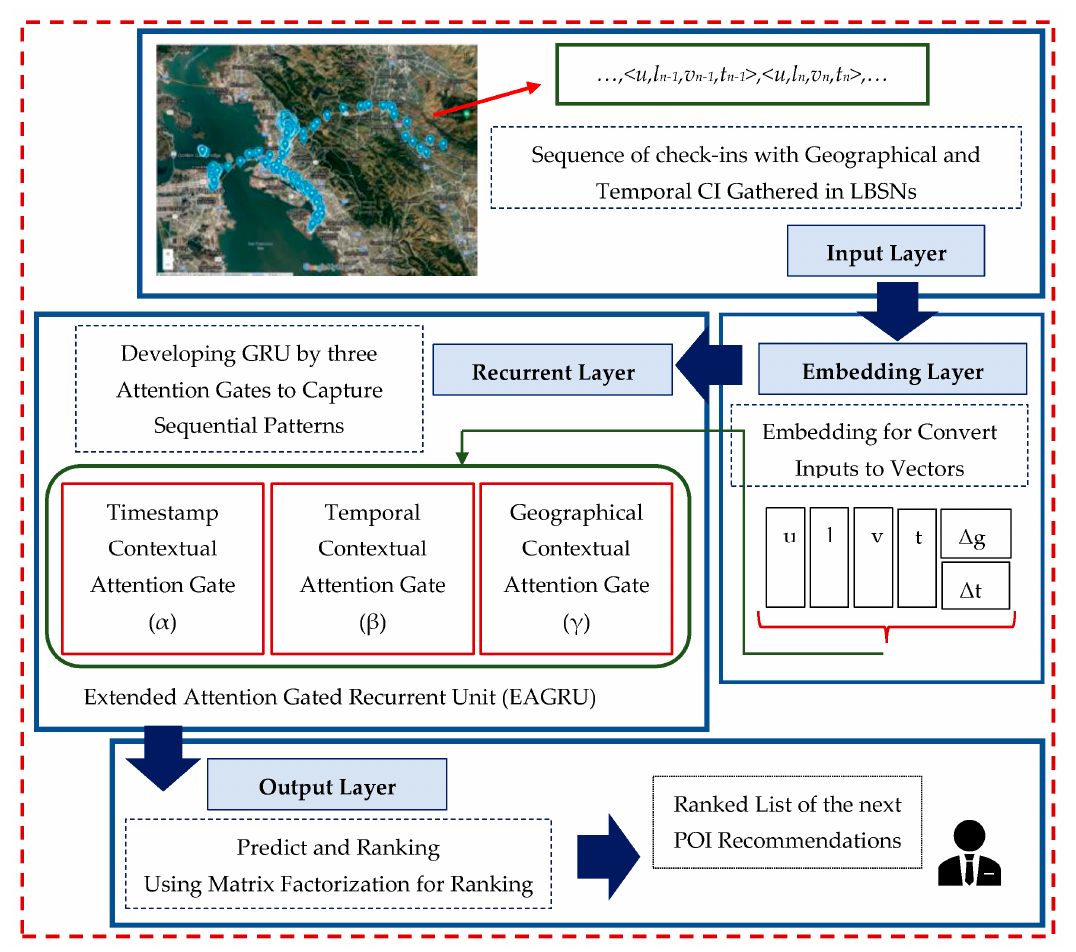
Figure 3. EAGRU’s general architecture. Historical check-ins are collected in LBSNs and used as input in the proposed model. The proposed EAGRU’s output is a ranked POI list that might be interesting to a user in the future based on historical sequences of check-ins at time t .